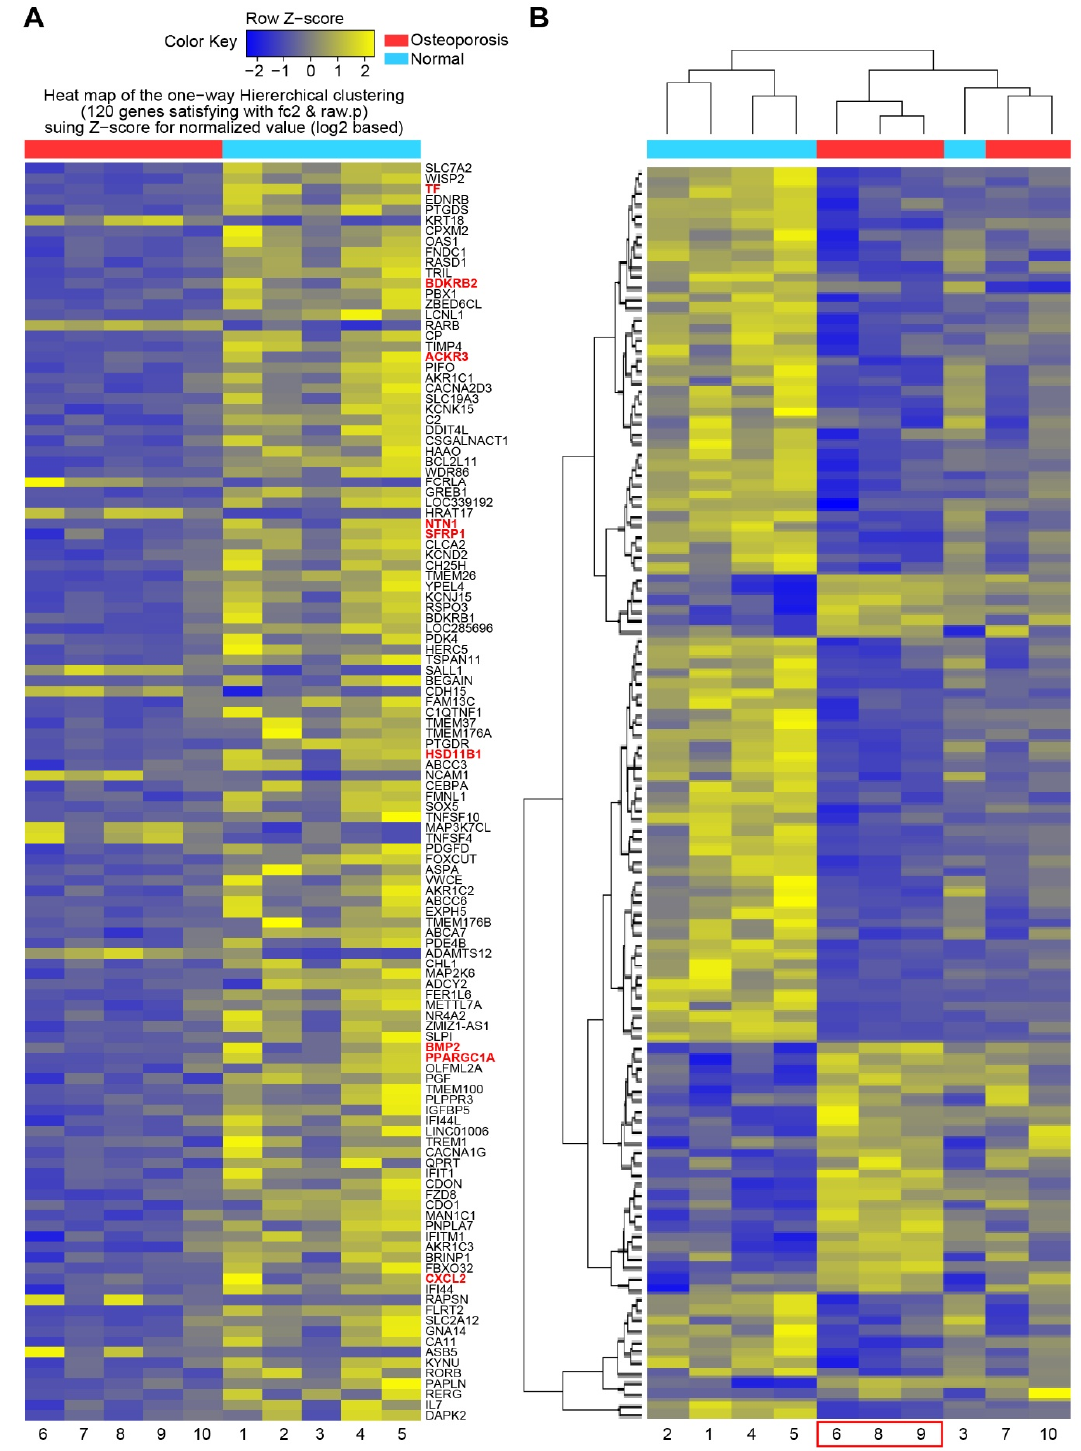
Figure 1. Heatmap of DEG of mesenchymal stromal cells from control and osteoporosis groups. ( A ) Heatmap of one-way hierarchical clustering of all samples showing 120 differentially expressed genes complying with |FC| ≥ 2, independent t-test raw p -value < 0.05, and Z-score for normalized value (log2 based). ( B ) Heatmap grouped by similarity of gene expression pattern via hierarchical clustering analysis of significant genes (distance measure = Euclidean distance; linkage method = completeness).